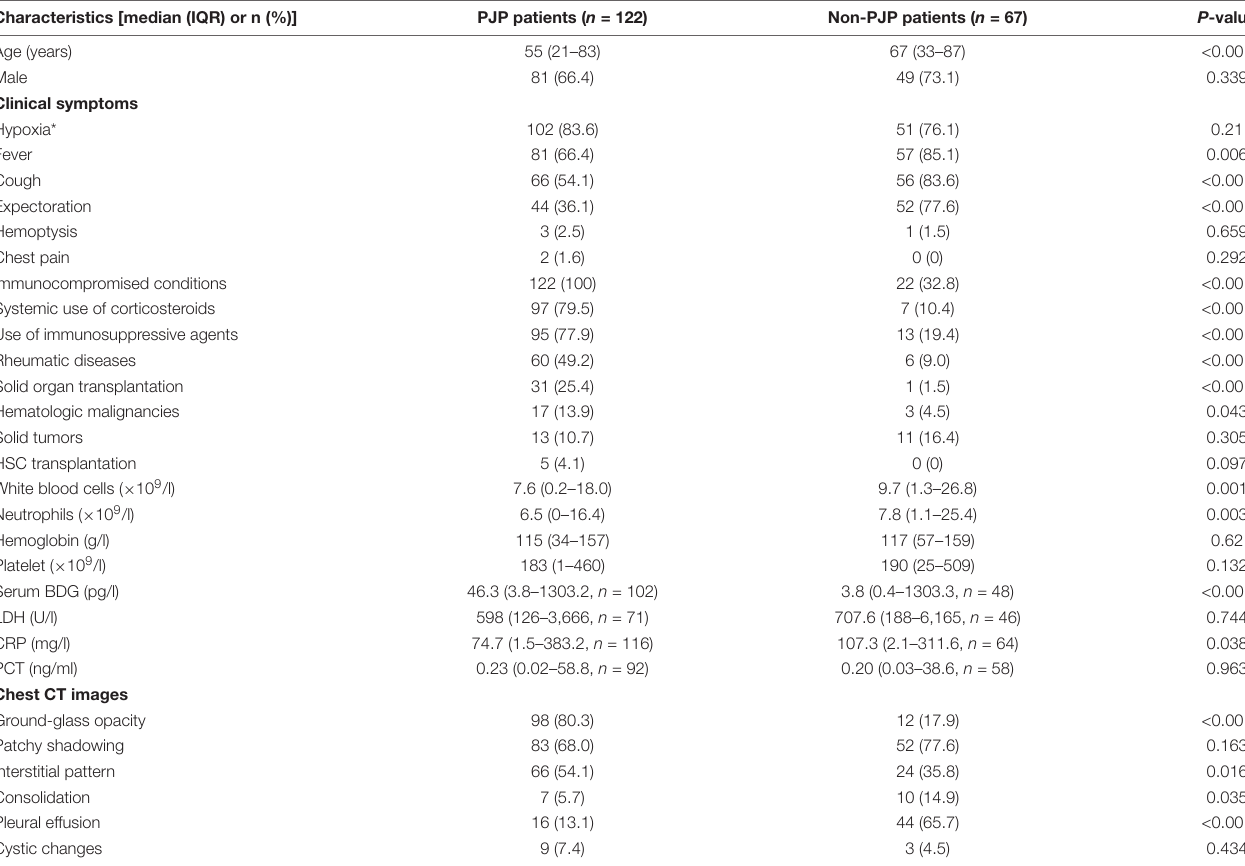
TABLE 1 | Clinical characteristics, laboratory examinations, and CT image results of the patients. Characteristics [median (IQR) or n (%)] PJP patients ( n =